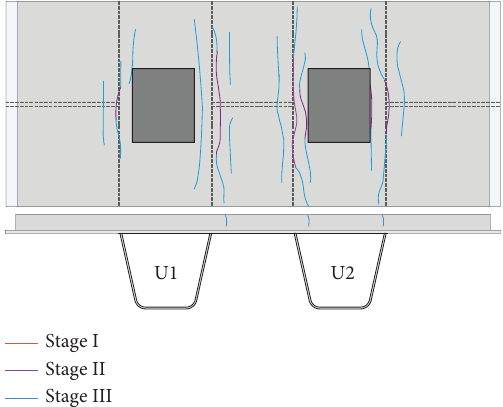
Figure 9: Crack distribution in UHPC layer.